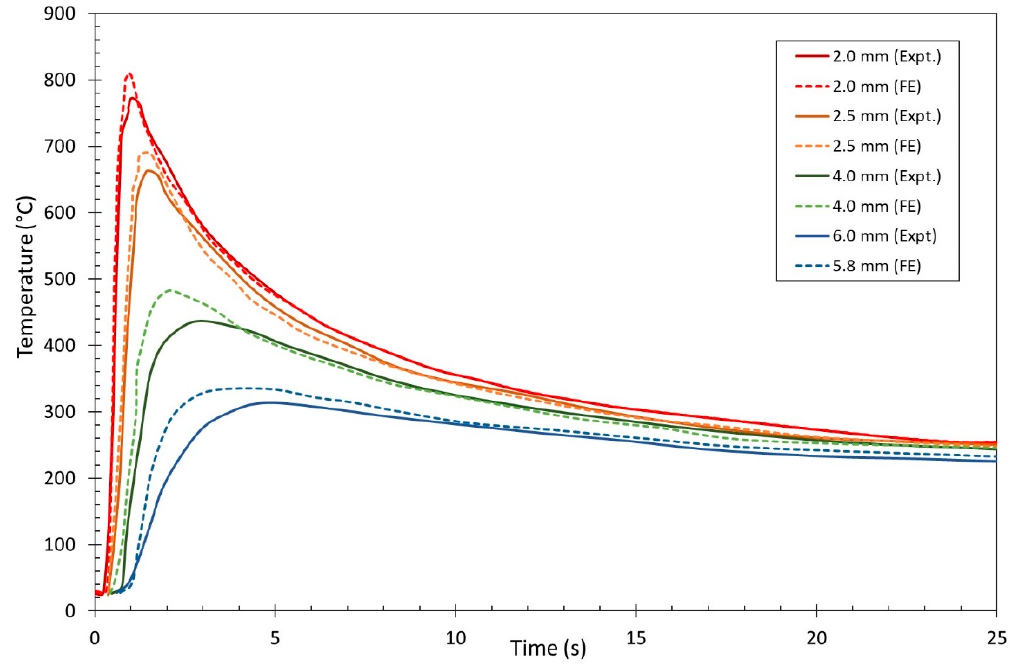
Figure 12 . Experimentally measured and FE-predicted thermal cycles at the specific thermocouple locations for plate weld d, which was a 3-mm-thick lamellar plate welded at 2 m min − 1 and 2.8 kW.